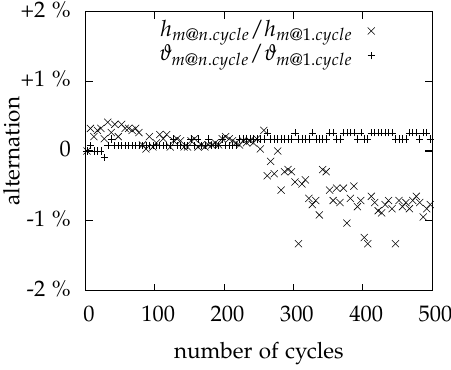
Figure 9: Density $ as a function of the temperature ϑ of the investigated PCM. The dashed line represents the linear fit of the measured points. Figure 10: Results of the cycling test with MCHH. The en- Figure 9. Results of the cycling test with MCHH. The enthalpies and temperatures of each cycle are thalpies and temperatures of each cycle are related related to the value of the first to the value of the first cycle.